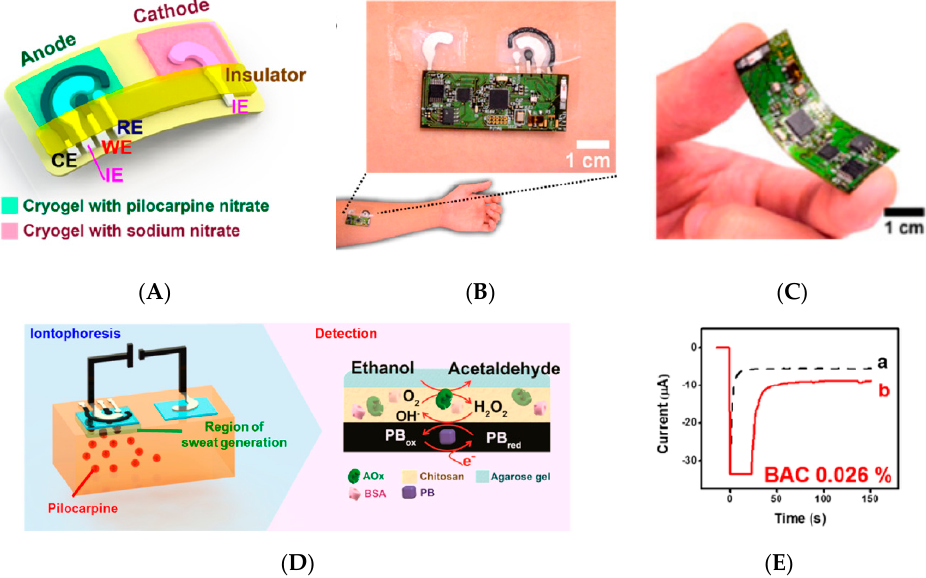
Figure 30. ( A ) Scheme of the iontophoretic flexible device, with the iontophoretic electrodes and the sensing electrodes. ( B ) Picture of the whole system (sensor with electronics) applied on the forearm of a subject. ( C ) Picture of the flexible wireless electronics. ( D ) Scheme of the constituents in the iontophoretic system (left) and in the amperometric electrode (right). ( E ) Experiments performed before (plot ‘a’) and after (plot ‘b’) consumption of 350 mL of beer measured on two different human subjects. Reproduced from [92] with permission. Copyright © 2016, American Chemical Society.